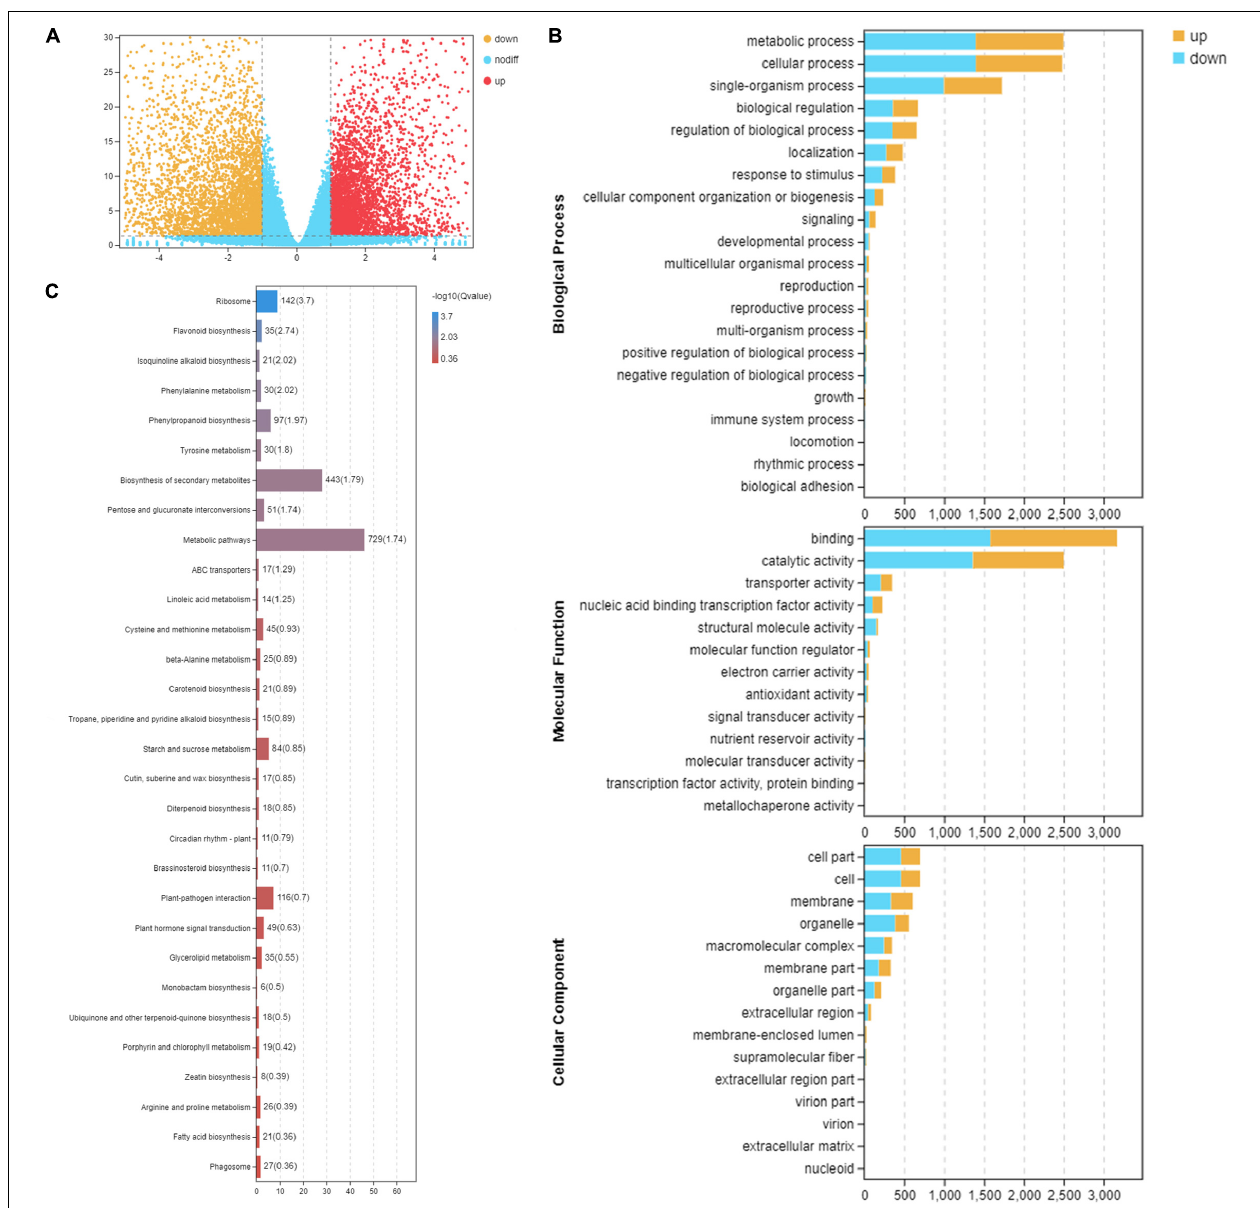
FIGURE 2 | Functional analysis of differentially expressed genes between consecutive developmental stages. (A ) The volcano distribution map of differentially expressed genes in the leaves at stage 1 (S1) and stage 4 (S4) on RNA-seq experiments. The genes were classified into three classes. Yellow genes are up-regulated gene expression, red indicates up-regulated gene expression, and blue indicates genes were not differentially expressed. The x -axis represents log 2 (fold change); the y -axis represents -log10 values. (B) Gene Ontology enrichment analysis in pairwise comparison between S1 and S4. Yellow indicates up-regulated genes, and blue indicates down-regulated genes. (C) Kyoto Encyclopedia of Genes and Genomes pathway enrichment analysis in pairwise comparison between S1 and